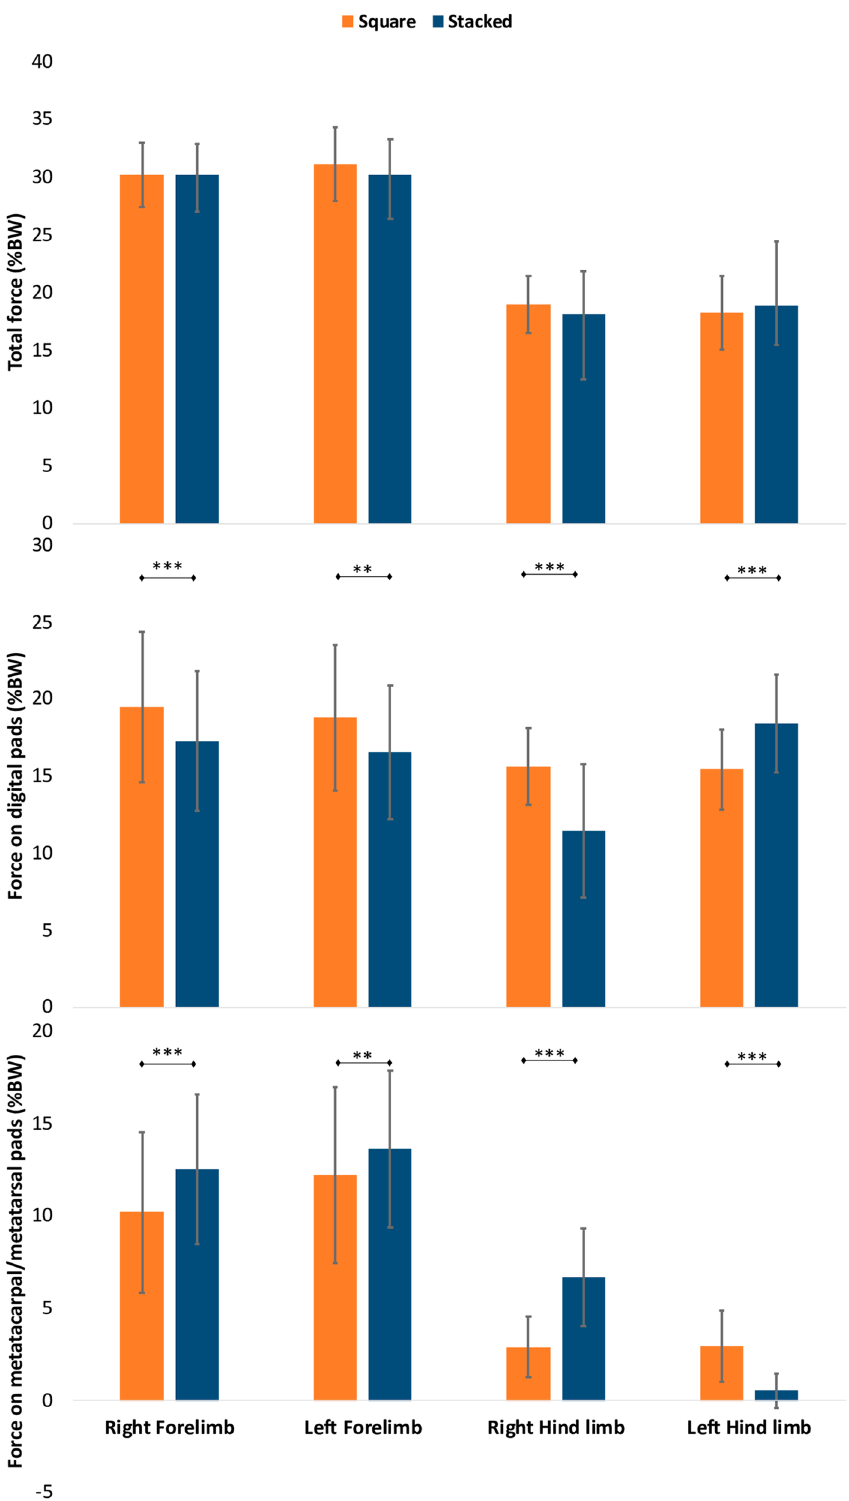
Figure 5. Vertical force supported by the limbs, digital pads, metacarpal/metatarsal pads of each limb when standing square and in the stacked position expressed as a percentage of body weight (BW), showing the mean and standard deviation for the 60 GSDs. Significant differences are indicated using *For p < 0.05, **for p < 0.01, **for p <